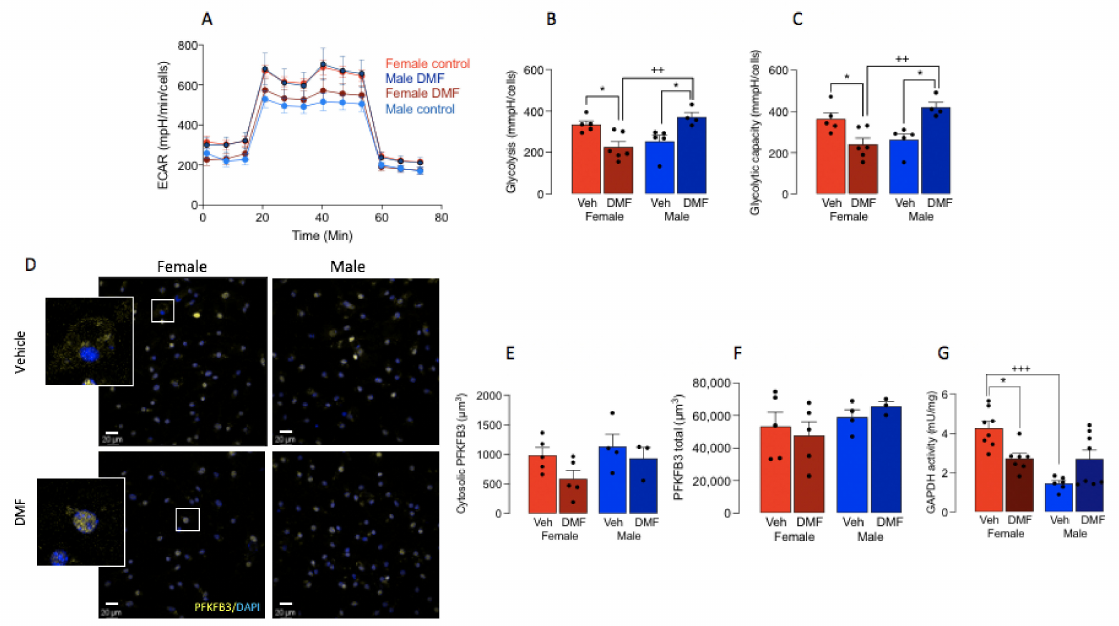
Figure 3. DMF modulates microglial metabolism. ( A ) Analysis of the metabolic profile of microglia isolated from DMF- and control-treated mice indicated that DMF decreased ECAR in cells from females and increased ECAR in cells from males. ( B , C ) Analysis of glycolysis and glycolytic capacity indicated significant treatment x sex interactions ( p < 0.001) and post hoc analysis indicated that both values were significantly decreased in microglia prepared from DMF-treated female, compared with vehicle-treated female mice (* p < 0.03) and DMF-treated male, mice ( ++ p < 0.01). Glycolysis and glycolytic capacity were significantly increased in cells from DMF-treated male mice, compared with vehicle-treated male mice (* p < 0.05). ( D , E ) PFKFB3 (yellow) assessed in isolated microglia from DMF- and vehicle-treated male and female mice. The sample immunograph suggests that DMF increased cytosolic staining of PFKFB3 in female, but not male, mice and increased translocation to the DAPI-stained nucleus (blue). The mean data ( E ), 3 coverslips/mouse, average number of cells counted/coverslip = 48) indicate a clear difference between treatment groups in females but no statistically significant changes were observed. No change in total PFKFB3 ( F ) staining was observed. Scale bar = 20 µ m. ( G ) Analysis of GAPDH activity revealed that there was a significant sex x treatment interaction ( p < 0.001) and post hoc analysis indicated a significant decrease in tissue from female DMF-treated mice compared with female vehicle-treated mice (* p < 0.05) and DMF-treated male mice ( +++ p < 0.001). Data from 2 or 3 experiments are presented as means ± SEM ( n =